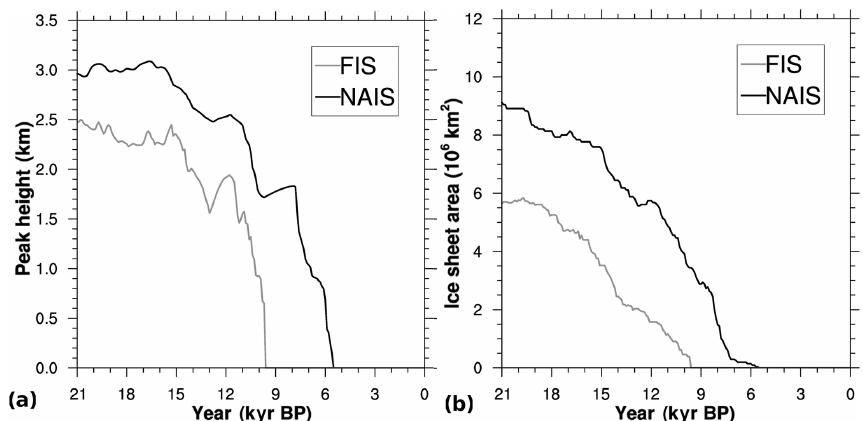
Figure 1. (a) Peak elevation in ice-sheet-covered areas (bedrock elevation plus ice sheet thickness) and (b) ice sheet area for the component of the Laurentide ice sheet and Eurasia